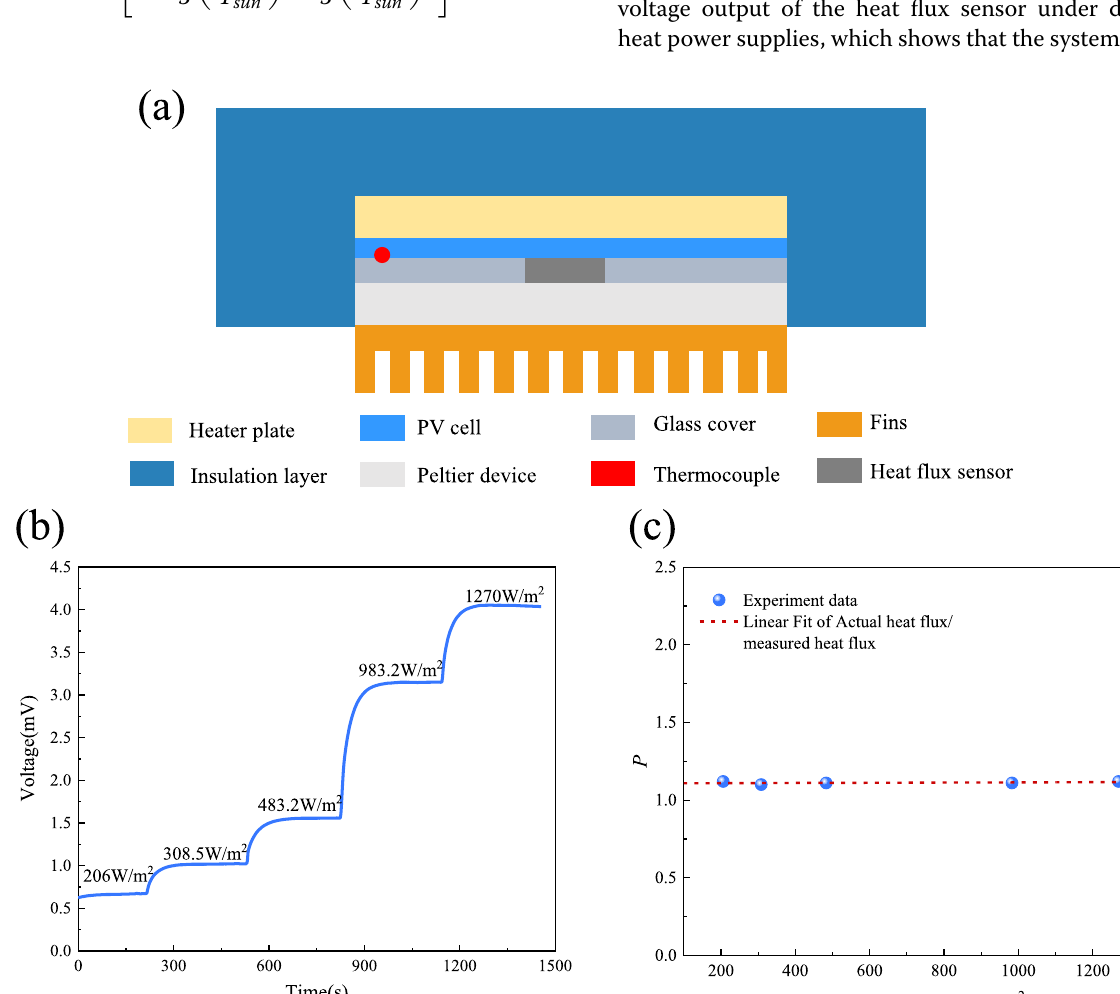
Fig. 8 a Calibration testing system. b Variation in the voltage of the heat flux sensor. c The ratio P is the ratio of actual heat flux to measured heat flux under different heating